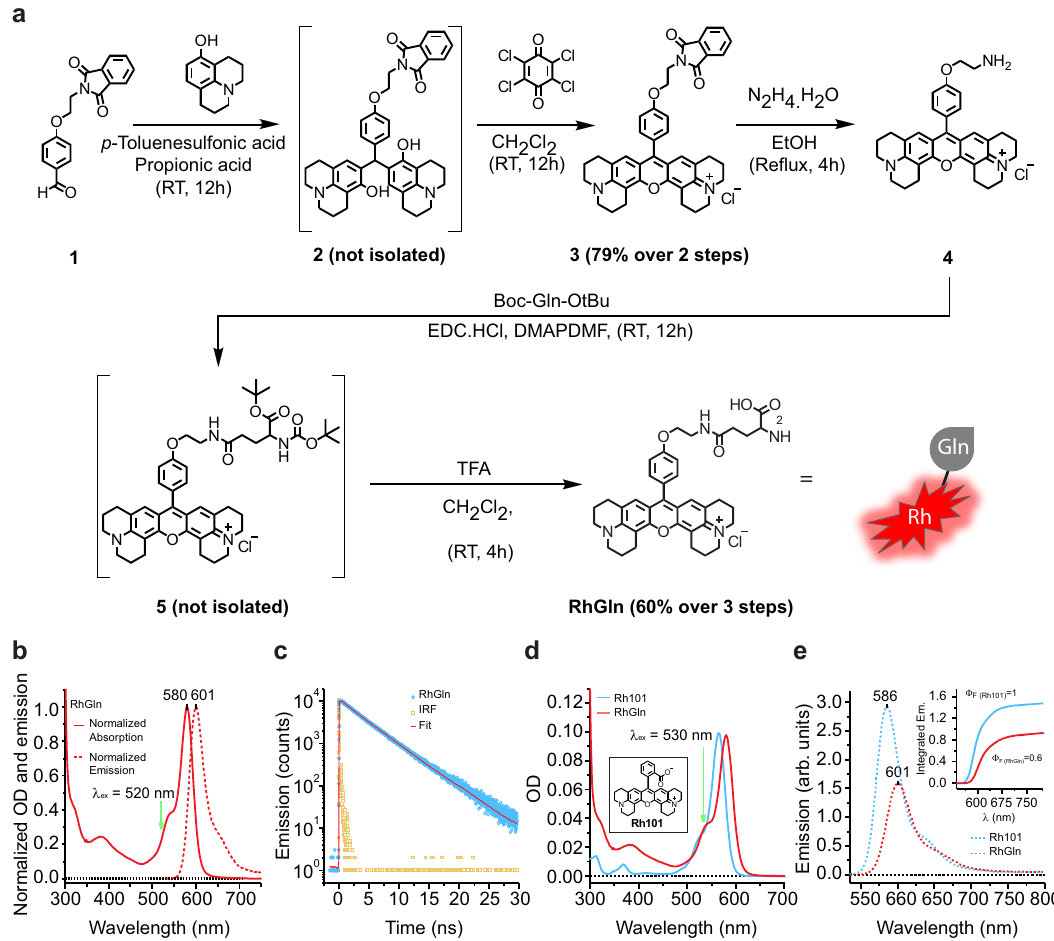
Fig. 1 Synthesis and characterization of fl uorescent rhodamine-tagged glutamine (RhGln) molecule. a Fluorescent RhGln molecule was prepared using a 5-step chemical synthesis with 48% overall yield. b Characterization of steady-state electronic absorption (solid line) and emission (dotted line) spectra of RhGln at excitation wavelength ( λ ex ) of 520 nm in intracellular solution at 20 °C, showing sharp absorption and emission maxima of 580 and 601 nm, respectively. c Fluorescence lifetime decay of RhGln in intracellular solution at λ ex of 520 nm (blue circles). The instrument response function (IRF, orange squares) and fi tted line (Fit, red) are also shown. d , e Comparison of absorption ( d ) and emission ( e ) spectra between RhGln (red line, 0.83 µ M) and its rhodamine precursor (Rh101, blue line, 0.94 µ M) at an λ ex of 530 nm in intracellular solution at 20 °C is shown with a relative fl uorescence emission quantum yield value ( Φ F ) of 0.6 for RhGln